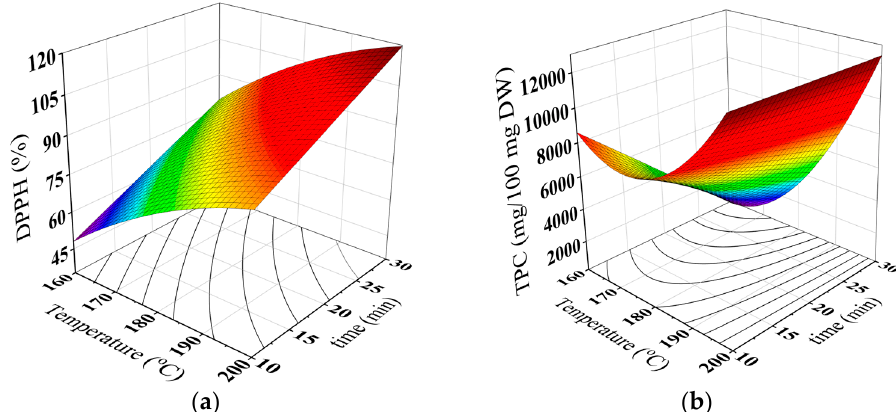
Figure 3. Three-dimensional surface plots for DPPH radical scavenging activity ( a ) and total phenolic contents ( b ) of the brew as a function of roasting temperature and time.